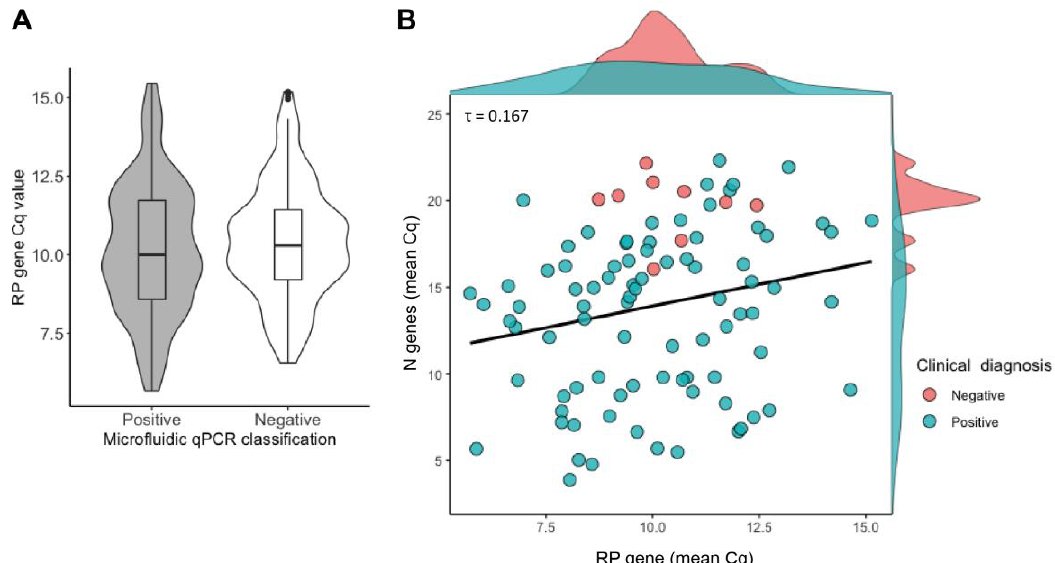
Figure 5. Low estimated viral titers are not due to poor quality samples. ( A ) Violin plots of RP gene Cq values across samples with positive and negative microfluidic qPCR results. There is no significant difference between the two groups (Welch’s t -test, p -value = 0.08). ( B ) Scatter and density plots of N gene vs. RP gene Cq values from microfluidic qPCR for samples with negative or positive clinical diagnostic results. Cq values for viral N and host RP genes are not strongly correlated overall ( τ = 0.167, p -value = 0.017).